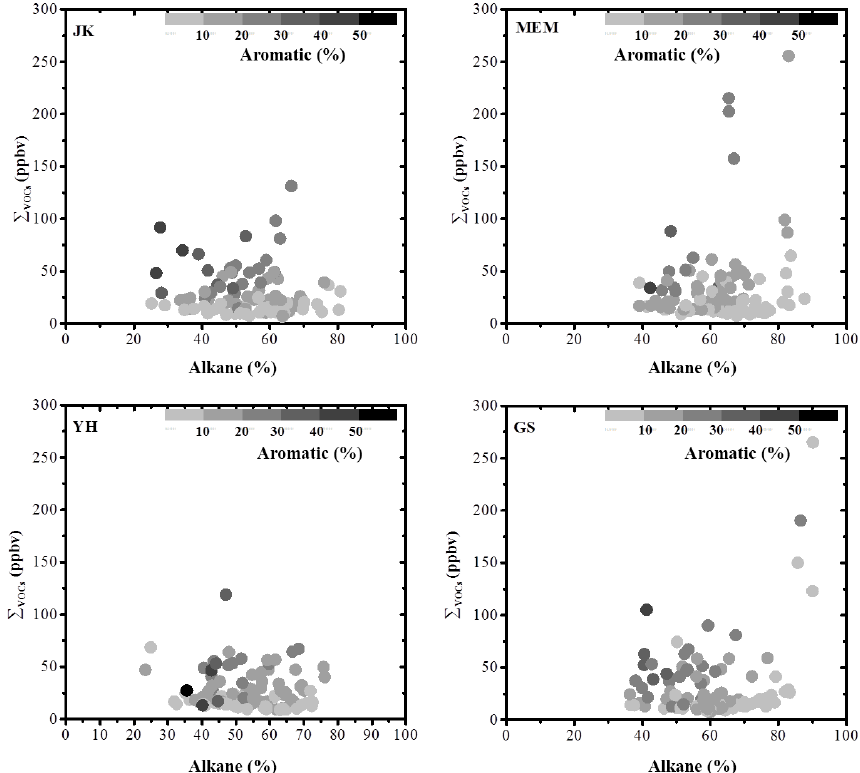
Figure 7. The relationship between the mixing ratio of (cid:54) VOCs and the composition of alkane. The data points are color coded according to the composition of aromatic.